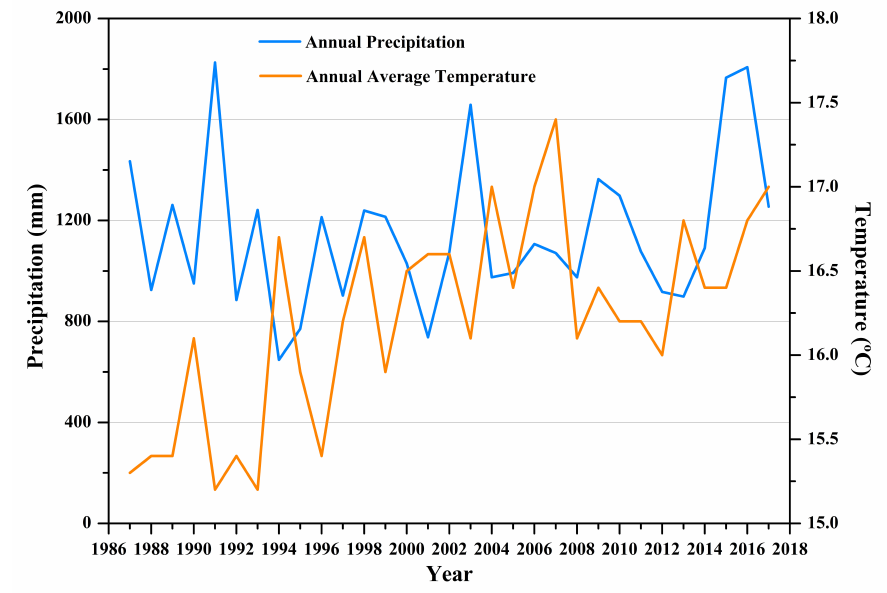
Figure 2. Average annual precipitation and average temperature changes in the study